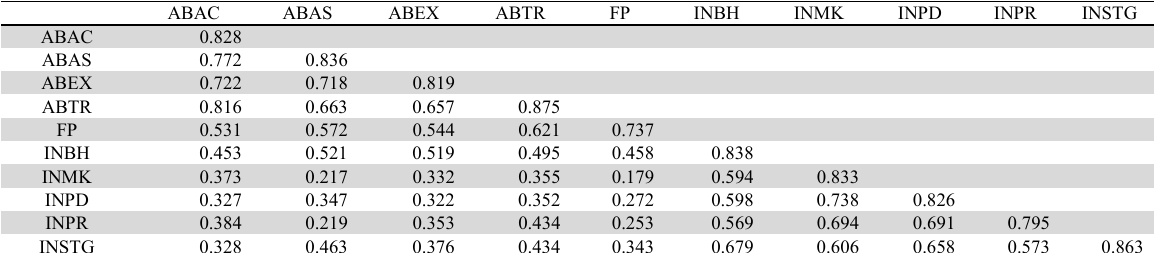
Fornell-Larcker Criterion ABAC